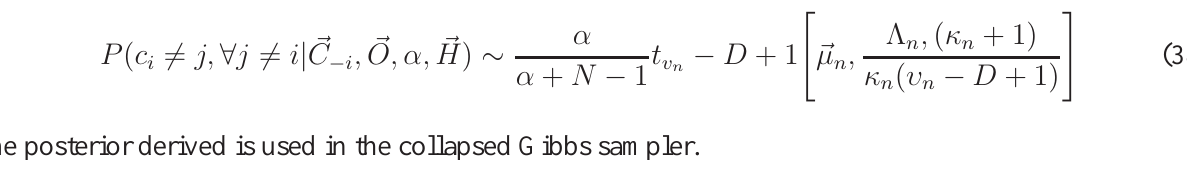
Algorithm 1 : Non-parametric Bayesian clustering algorithm for human motion recognition using collapsed Gibbs